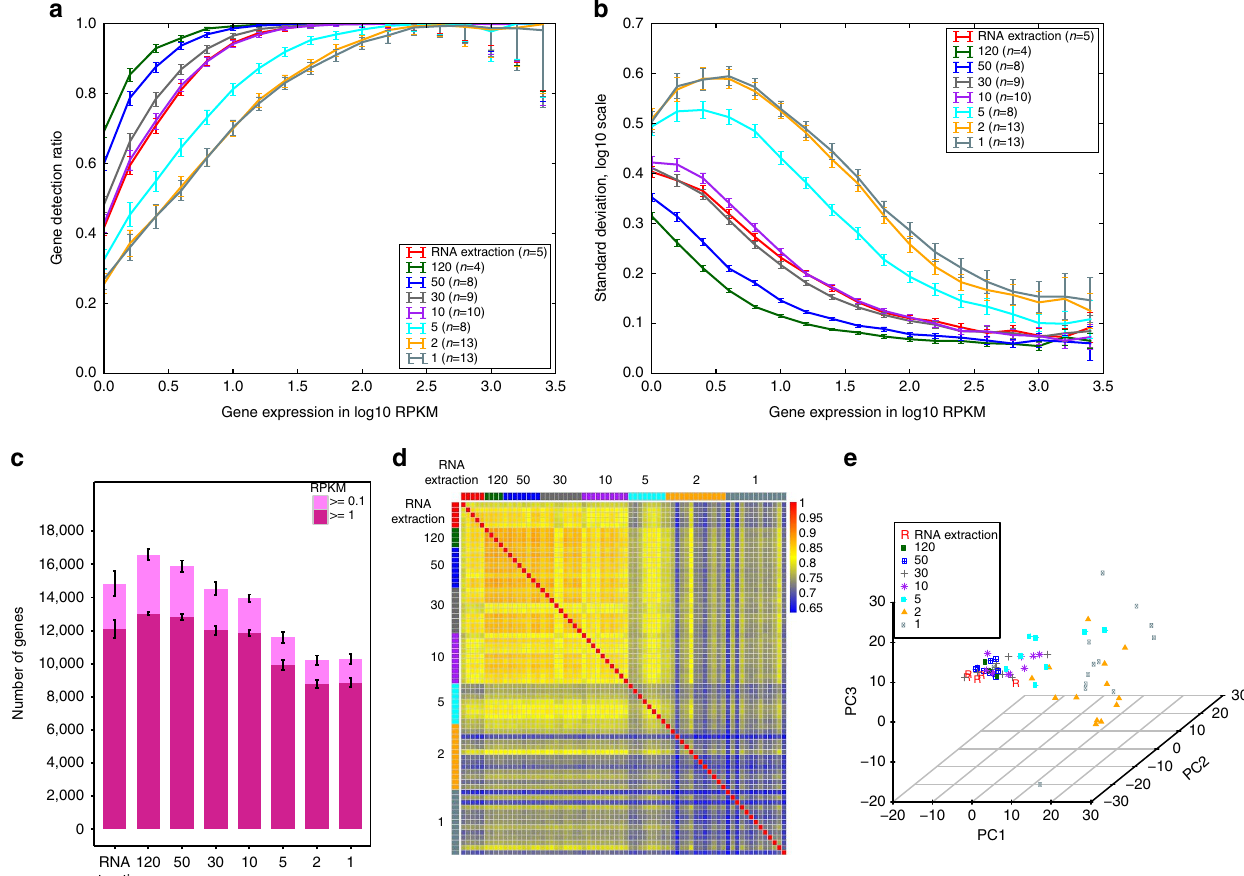
Figure 2 | LCM-seq improved the sensitivity of gene detection and is applicable to single cells. ( a ) Reproducibility of detected genes was evaluated by comparing all possible pairwise comparisons within replicates of each group (control RNA extraction and 120, 50, 30, 10, 5, 2 and 1 LCM-seq samples), shown as mean with 90% confidence interval of reproducible ratios. LCM-seq improved reproducibility of detection of low and medium level expressed genes compared to the RNA extraction protocol (RNA extraction) (mean ± s.e.m., n Z 4). ( b ) Standard deviation of gene expression within replicates binned according to gene expression levels. LCM-seq samples of 120–30 cells showed reduced technical variation for low and medium level expressed genes compared with the RNA extraction protocol (RNA extraction) (mean ± s.e.m., n Z 4). ( c ) Mean number of genes detected in the different sample groups (mean ± s.e.m.). A larger number of genes were detected in the 120 cell samples subjected to LCM-seq compared to the group subjected to RNA extraction before sequencing (0.1 RPKM as cutoff, P ¼ 0.04, Student’s t -test). ( d ) Gene expression correlation was high for 120, 50, 30 and 10 cell samples, while 5, 2 and 1 cell samples showed the heterogeneity among spinal MNs (Spearman’s correlation, genes expressed Z 1 RPKM in at least one sample were used). ( e ) PCA for all groups based on top 500 variable genes in expression confirmed the high similarity between 120 and the RNA extraction group as well as with 50, 30 and 10 cell LCM-seq